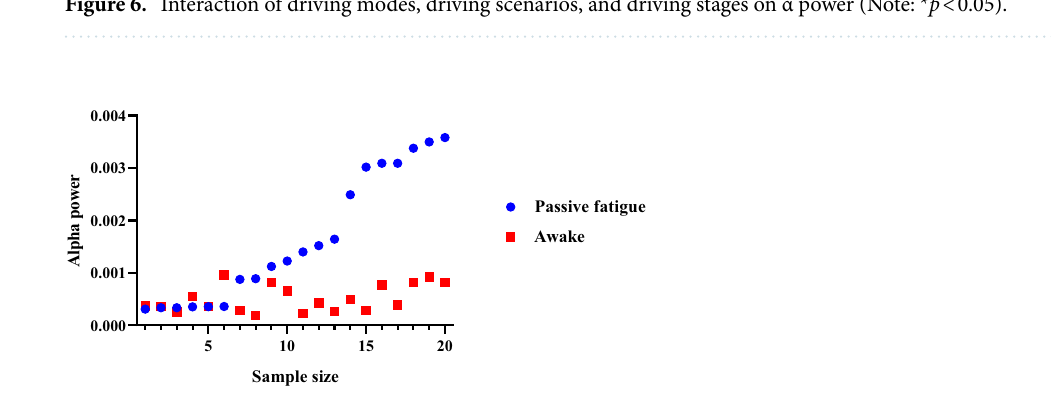
Figure 7. Scatter plot before and after passive fatigue.